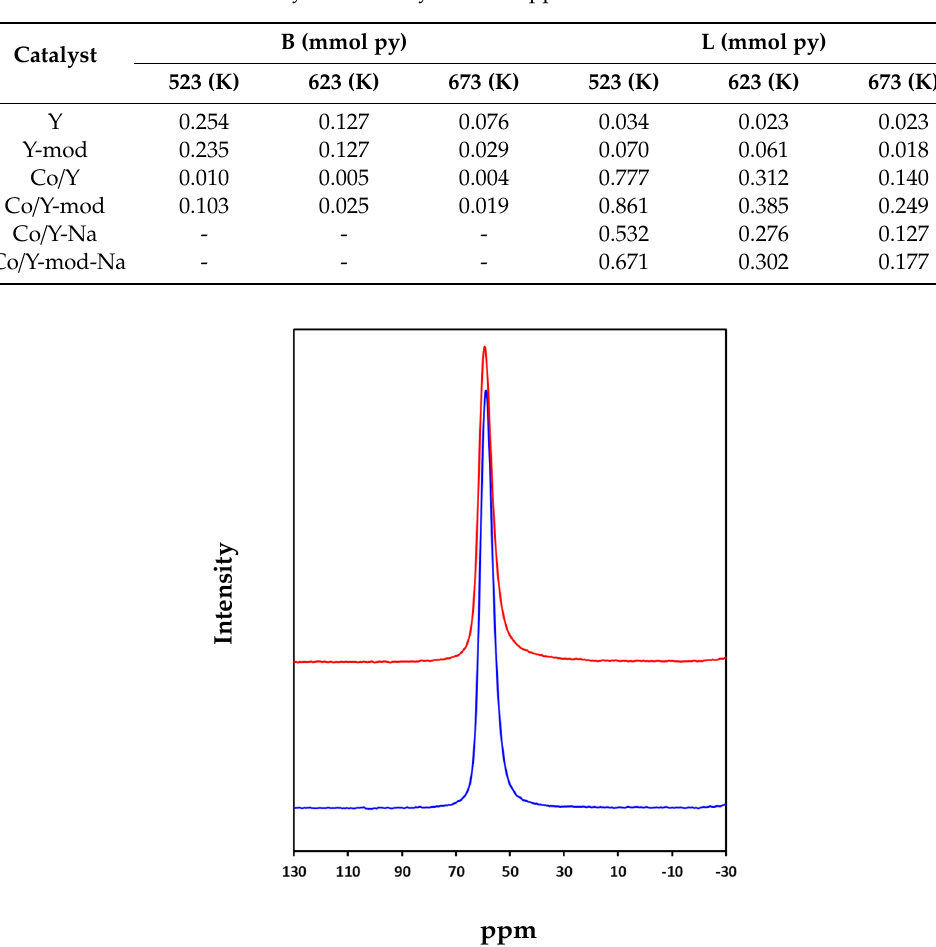
Table 3. Acidity of the catalysts and supports studied in this work.